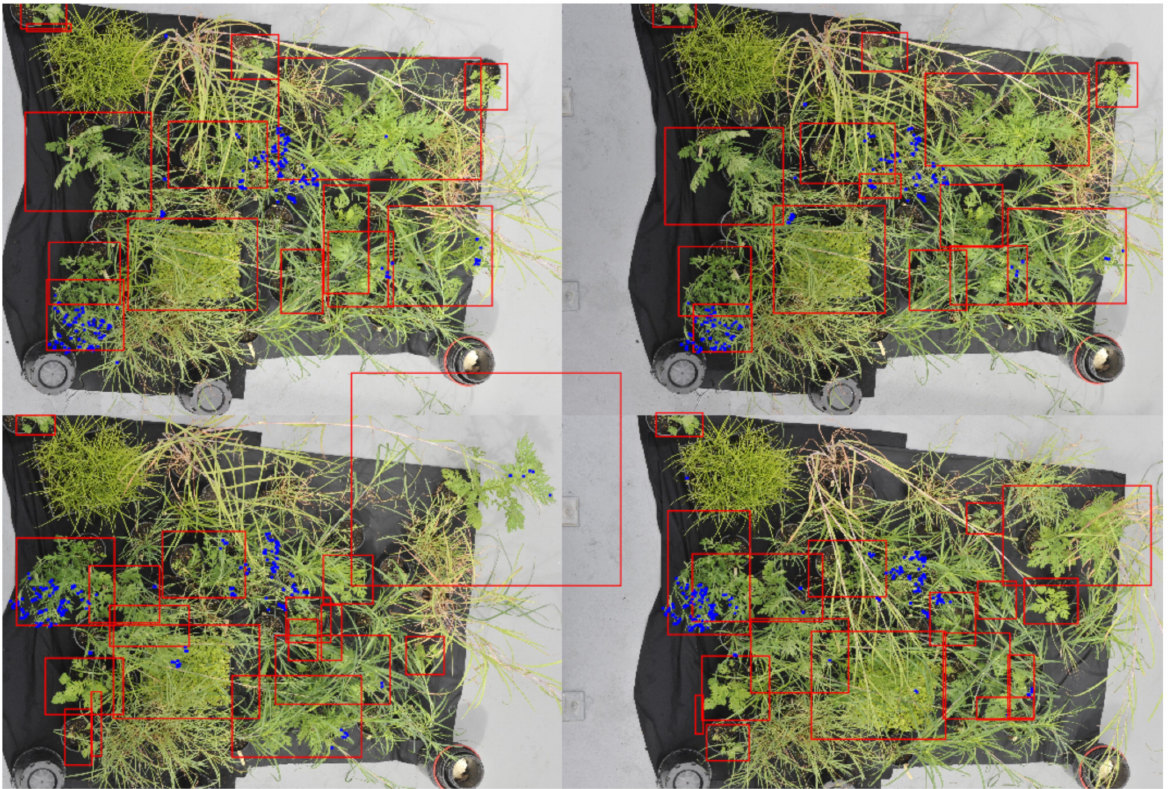
Figure 9. Examples of a simulated orthorectified image with parthenium weed detections in red and flower detections in